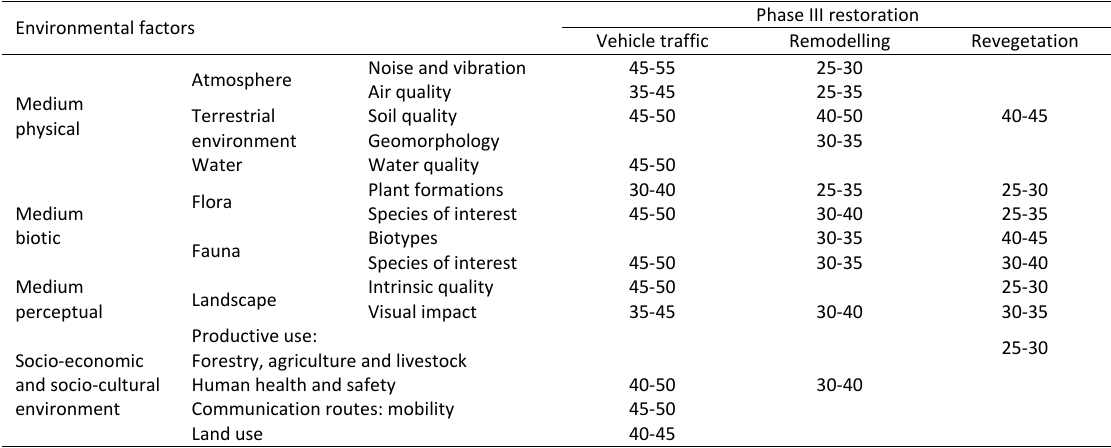
Table 6: Importance of the most significant environmental impacts in ornamental rock and aggregate quarries in the Region of Murcia in Phase III of